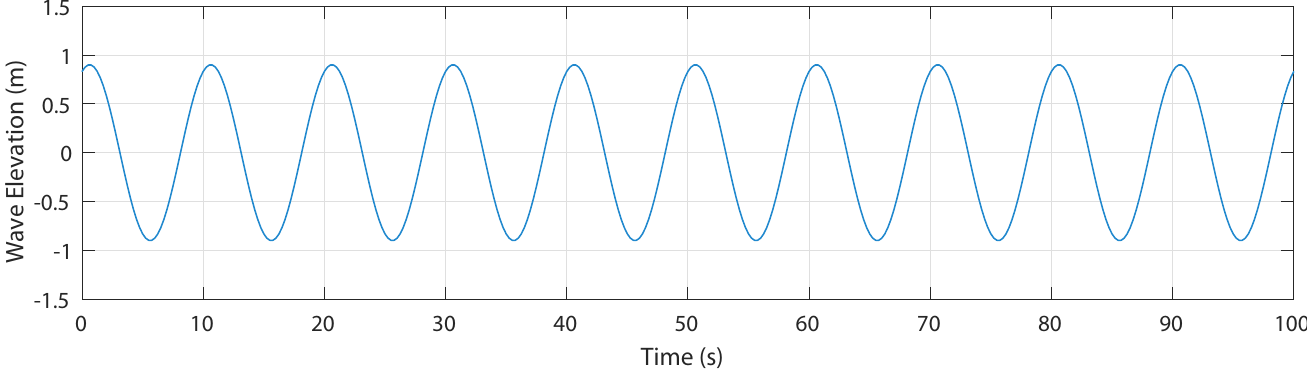
Figure 9. Wave elevation input.